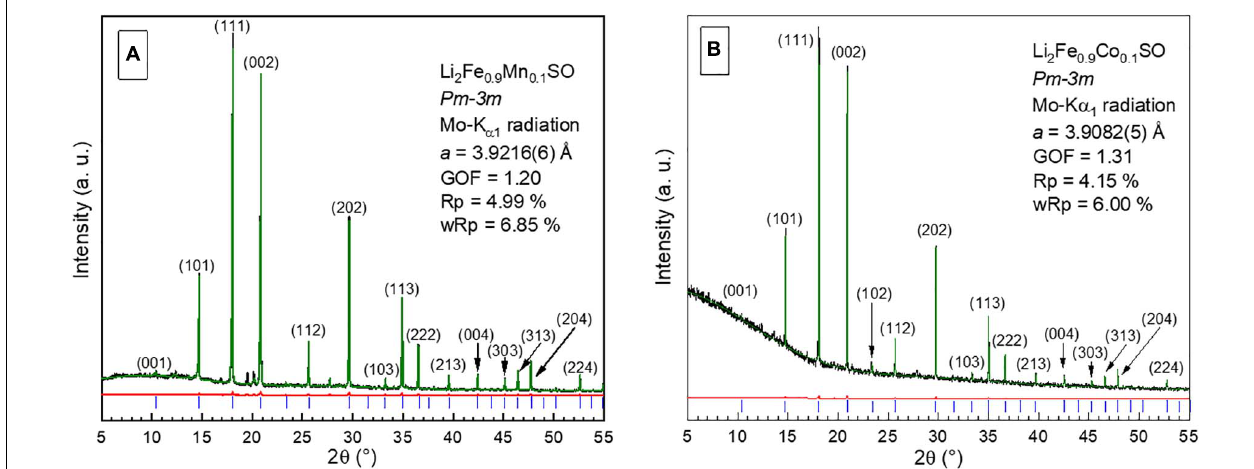
FIGURE 1 | Typical experimental diffractograms (black) of (A) Li 2 Fe 0 . 9 Mn 0 . 1 SO and (B) Li 2 Fe 0 . 9 Co 0 . 1 SO materials, together with the calculated (green) and difference (red) curves. Bragg positions are shown by blue dashes. Unindexed peaks in part (A) correspond to a small amount of metal sulfides.